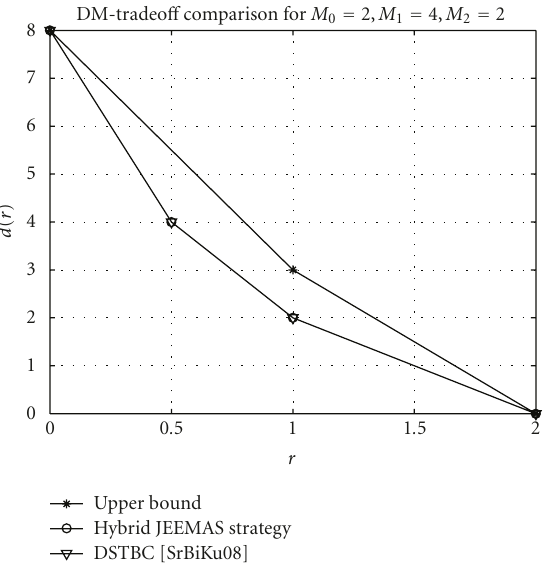
Figure 3: DM-tradeo ff comparison of hybrid JEEMAS with the strategy of